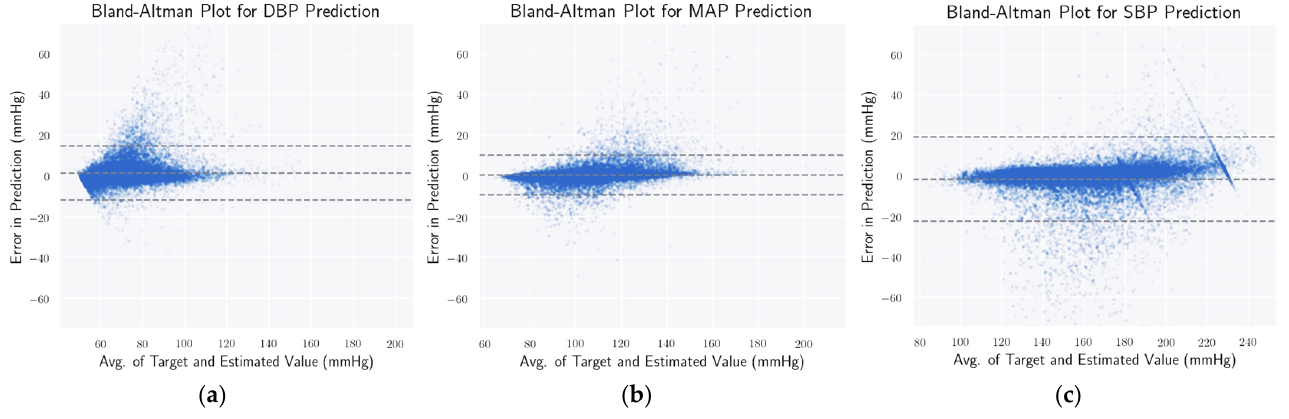
of the error terms fall within the 5-mmHg range. Nevertheless, all three plots contain a great chunk of outliers, especially the SBP plot (Figure 7c).